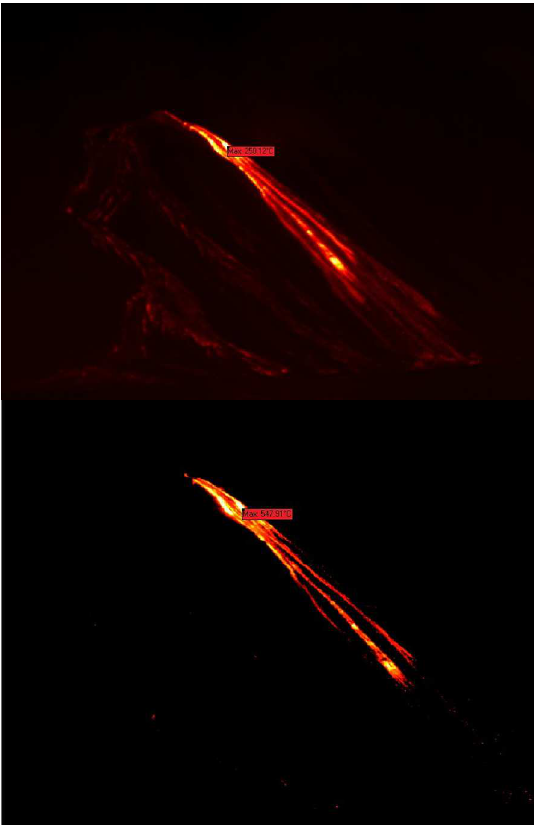
Figure 2. Observations with infrared cameras (TIR above, MIR below) from a boat in front of Sciara del Fuoco on Sep. 20 2014 around 19:50